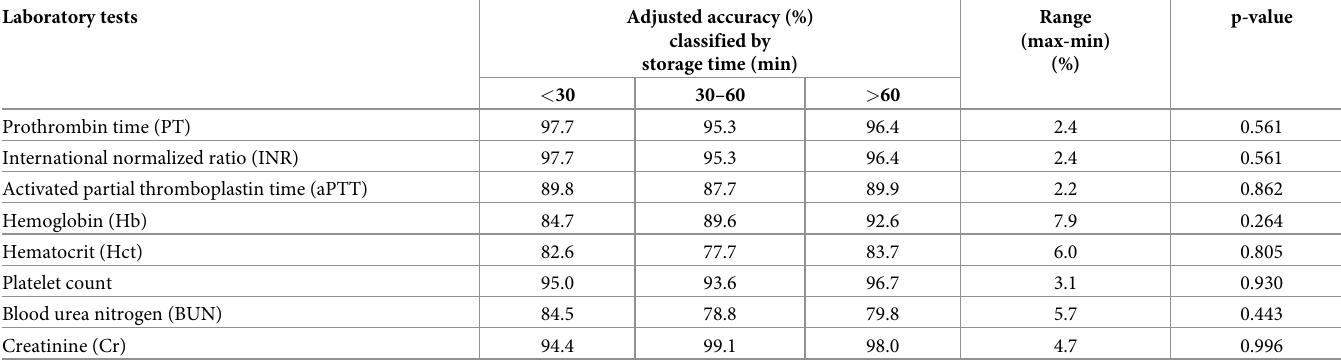
Table 3. Adjusted accuracy classified by storage time.